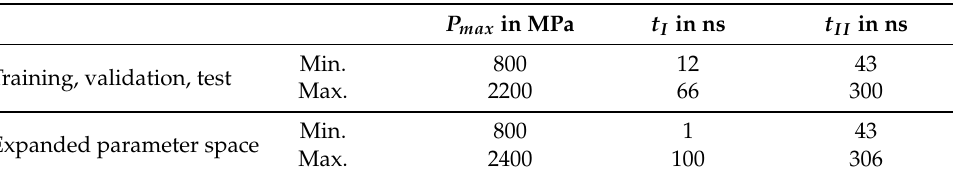
Table 5. Expanded pressure pulse parameter ranges of maximum pressure P max , time of maximum pressure t I and pulse duration t II as extrapolated parameter space in comparison to the ranges in the data set used for training, validation and testing, see Table 2. P max in MPa t I in ns